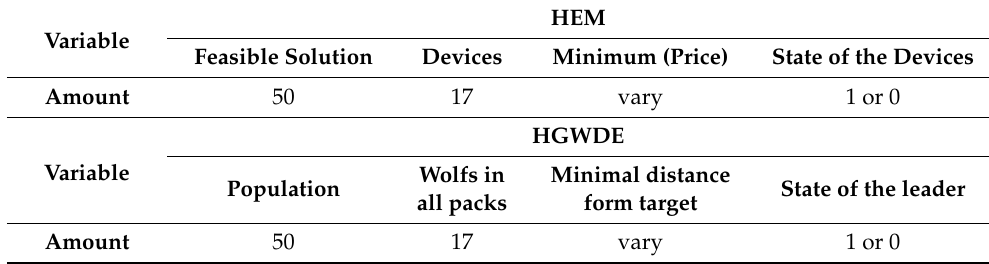
Table 2. HGWDE mapping on